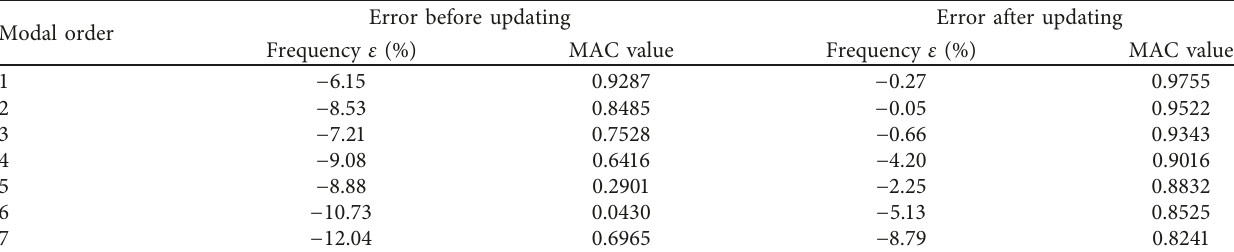
each direction. The comparison results are shown in The Z direction of the satellite sailboard (perpendicular to the plane of the board) is a key consideration for the sailboard under working conditions, and it is the most typical in a complex space environment. Four measurement points are arranged on the surface of the sailboard, i.e., at the fixed position of the sailboard, the middle of the sailboard close to the long side, the centre of the plane of the sailboard structure, and in the vicinity of a fire connection device.